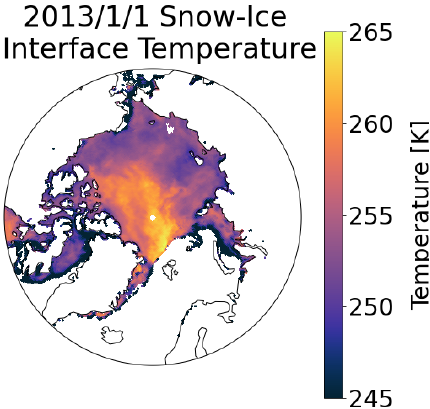
Figure 2. Snow–ice interface temperatures on 1 January 2013 de- rived from AMSR2